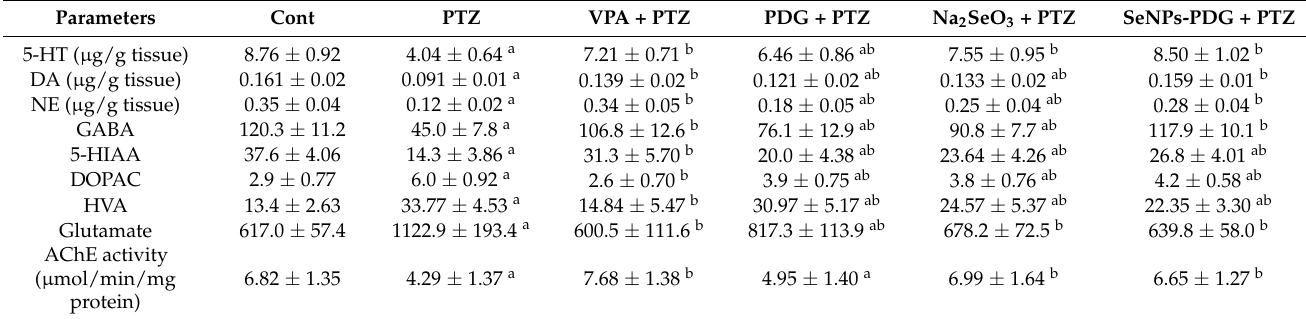
Table 3. Effects of orally administered prodigiosin (PDG), sodium selenite (Na 2 SeO 3 ), and green biosynthesized SeNPs with PDG (SeNPs-PDG) on the levels of monoamines, metabolites, and acetylcholinesterase activity in pentylenetetrazole (PTZ)-treated rats.